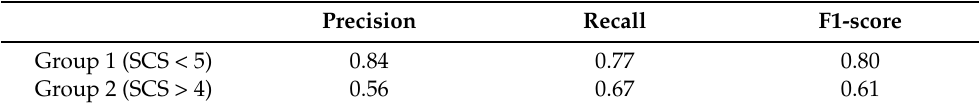
Figure 1. Receiver Operator Characteristic (ROC) curve for Surgical Complexity Score (SCS) to detect the cut-off value that predicts incomplete cytoreduction. A cut-off value of 4.5 was calculated, above which R0 resection is not achievable with a specificity of 86.5% (AUC = 0.644 CI = 0.598–0.69) The performance results of the created model are shown in Table 2. Table 2. XGBoost: precision, recall, and F1-score for both classes, namely Group 1 (SCS < 5) and Group 2 (SCS > 4).